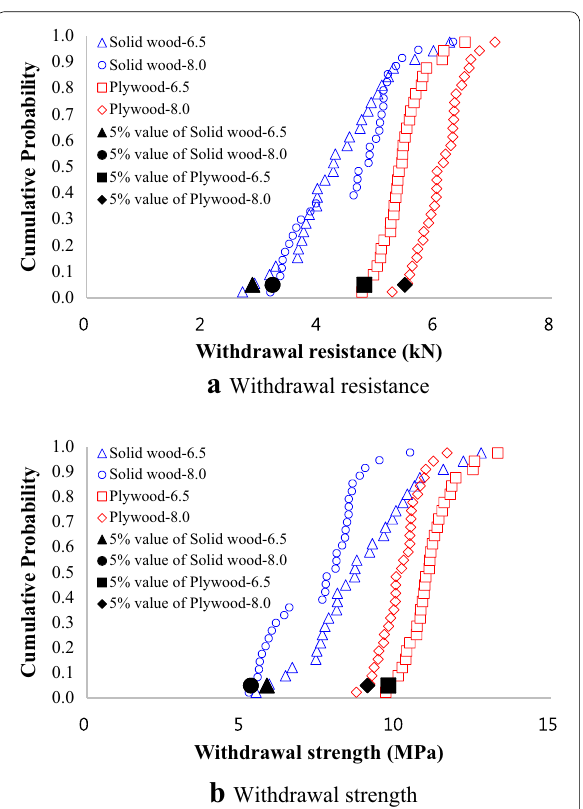
Fig. 9 Distribution of withdrawal capacity for Ply‑lam depending on the diameter of